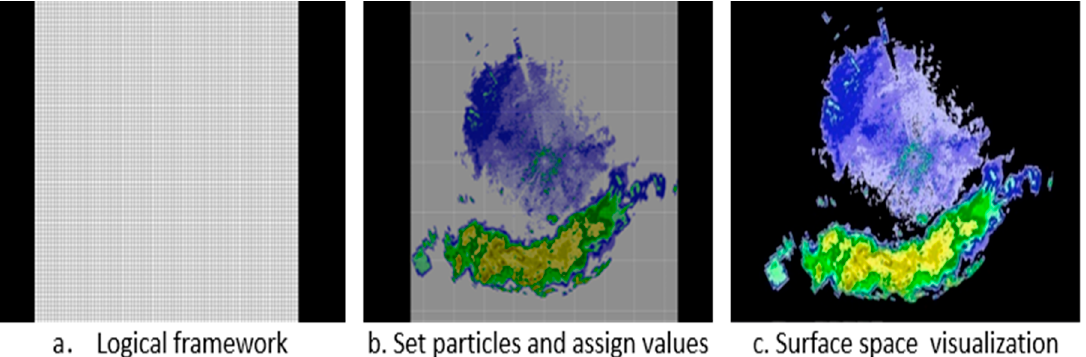
Figure 10. Visualization of a surface of radar data. ( a ) Logical framework; (b) Set particles and assign values; ( c ) Surface space visualization.